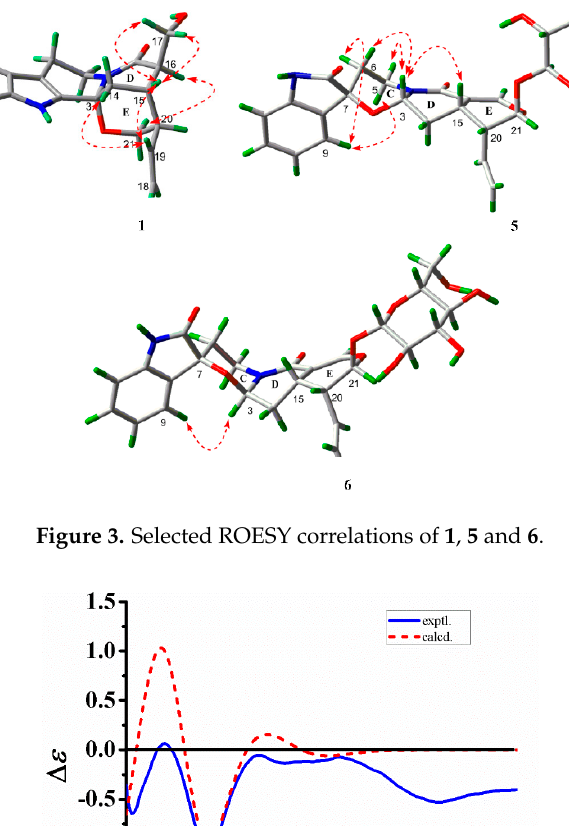
Table 2. 1 H (400 MHz) and 13 C (100 MHz) NMR data of nauclealomide A, 5 and 6 (CD 3 OD, δ in ppm, J in Hz).